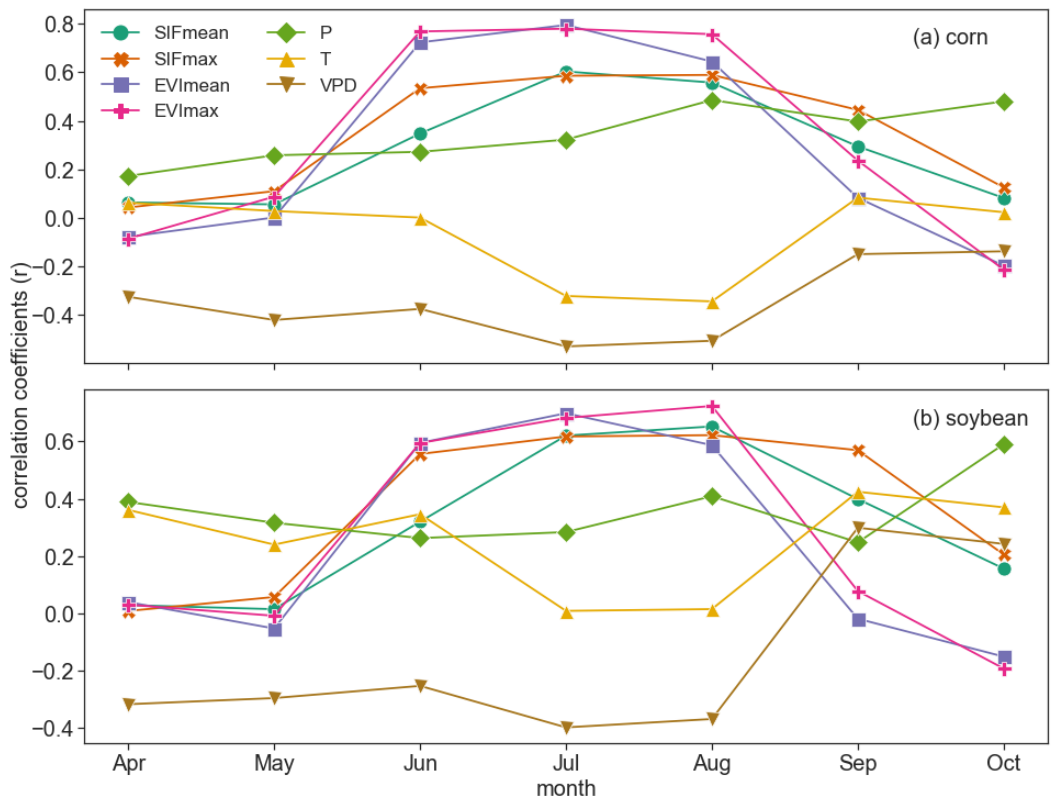
Figure 3. Correlation coe ffi cients of county-level corn ( a ) and soybean ( b ) yields with individual variables in di ff erent months. The SIF mean , EVI mean and climate variables are monthly mean values. The SIF max and EVI max are monthly maximum values (P = precipitation; T = temperature; VPD = vapor pressure